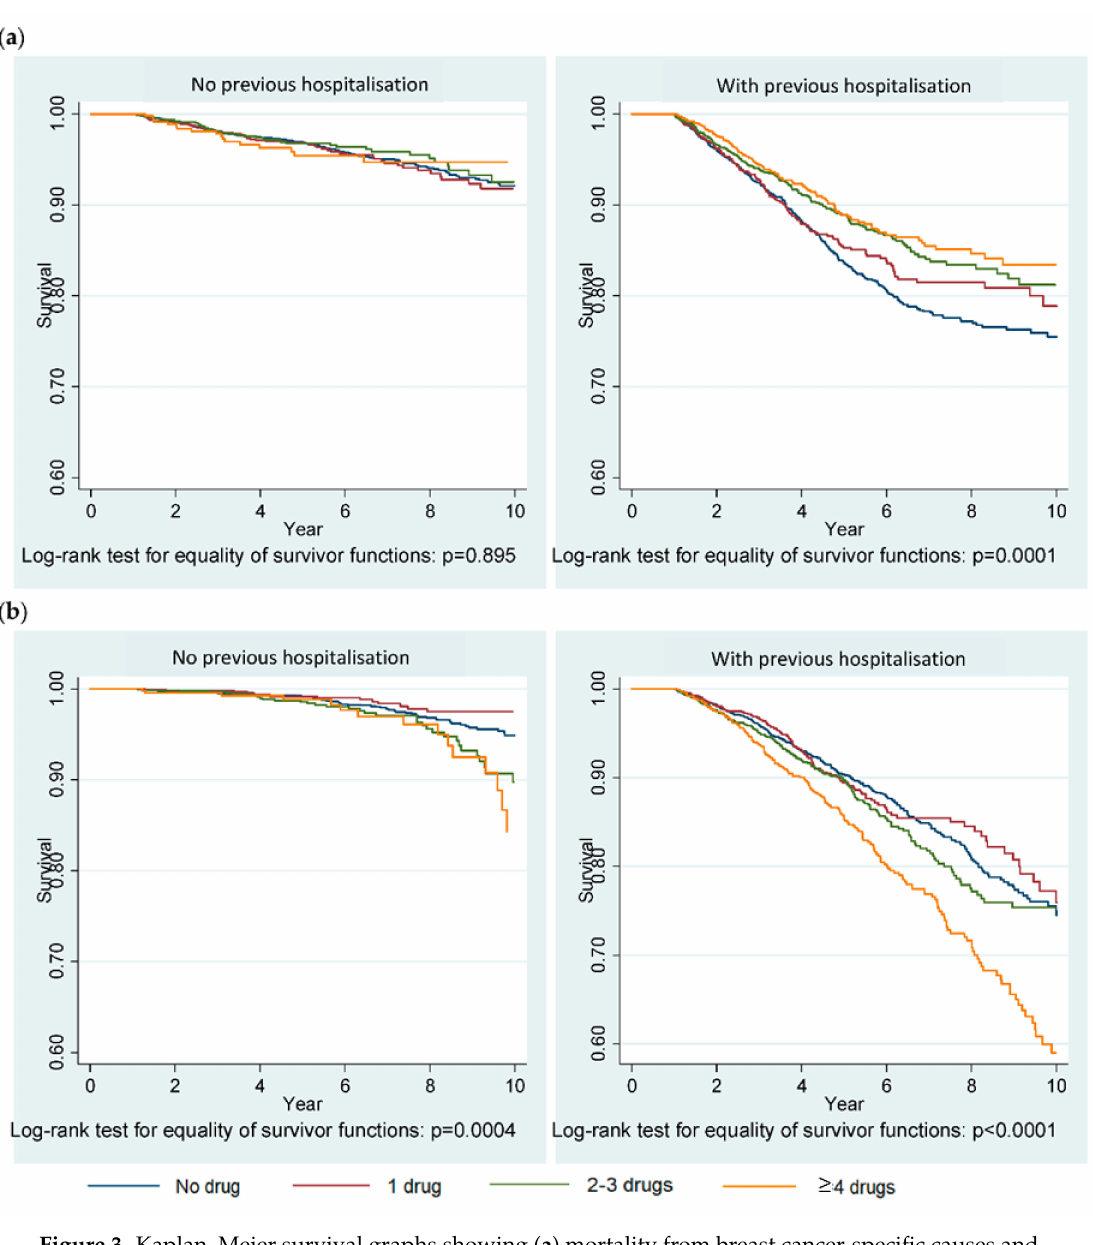
Figure 3. Kaplan–Meier survival graphs showing ( a ) mortality from breast cancer-specific causes and ( b ) mortality from other and unknown causes. Previous hospitalisation indicates presence of a severe comorbidity(-ies) that requires